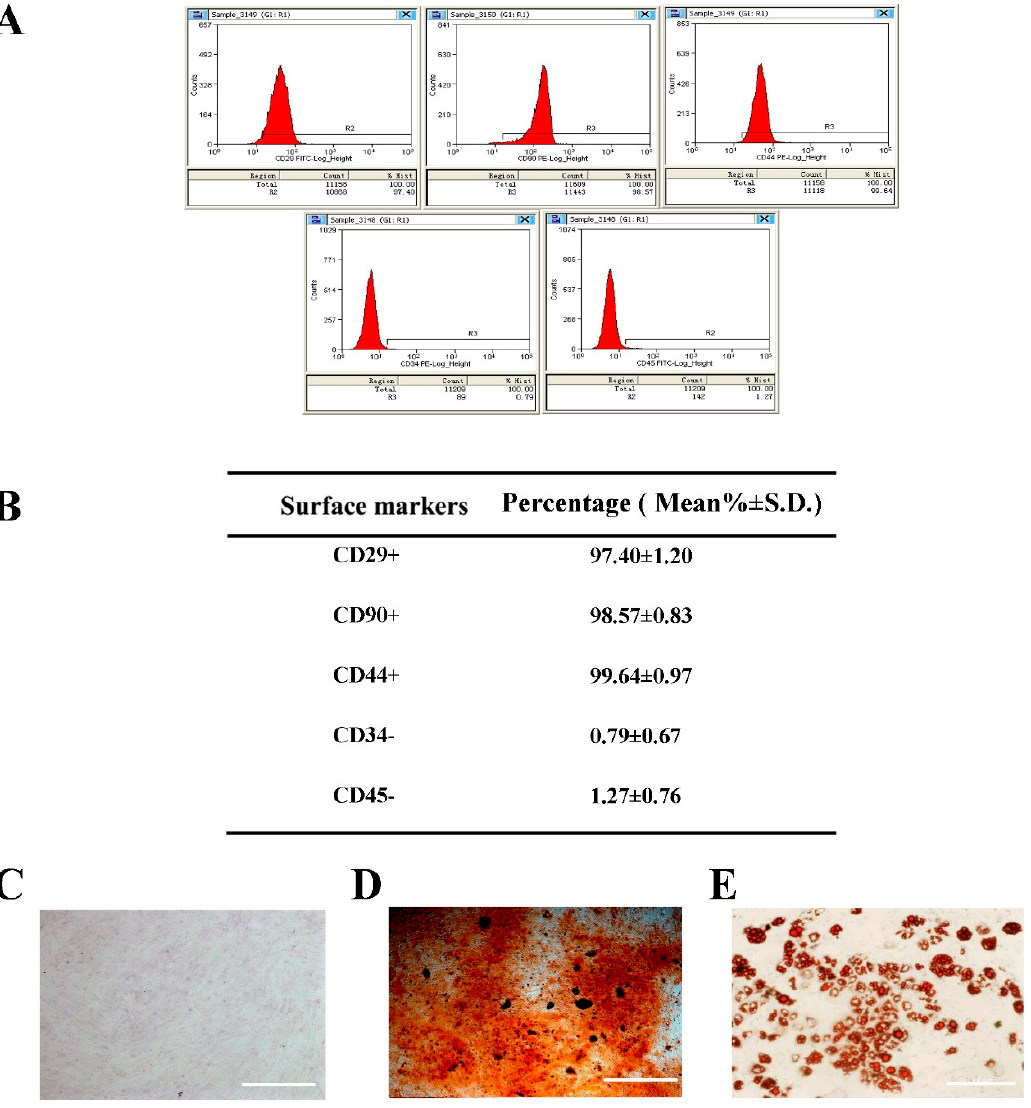
Figure 1. Characterization of BMSCs. ( A ) The expression of cell surface markers was evaluated by flow cytometry. Average of cells (%) are shown in ( B ) as Mean% ± S.D. (standard deviation). ( C – E ) The differentiation ability of BMSCs towards osteogenesis-like or adipogenesis-like cells was assessed by Alizarin Red S staining ( D ) or Oil Red O staining ( E ). The “white” scale bars represent 100 µ m (original magnification ×100).